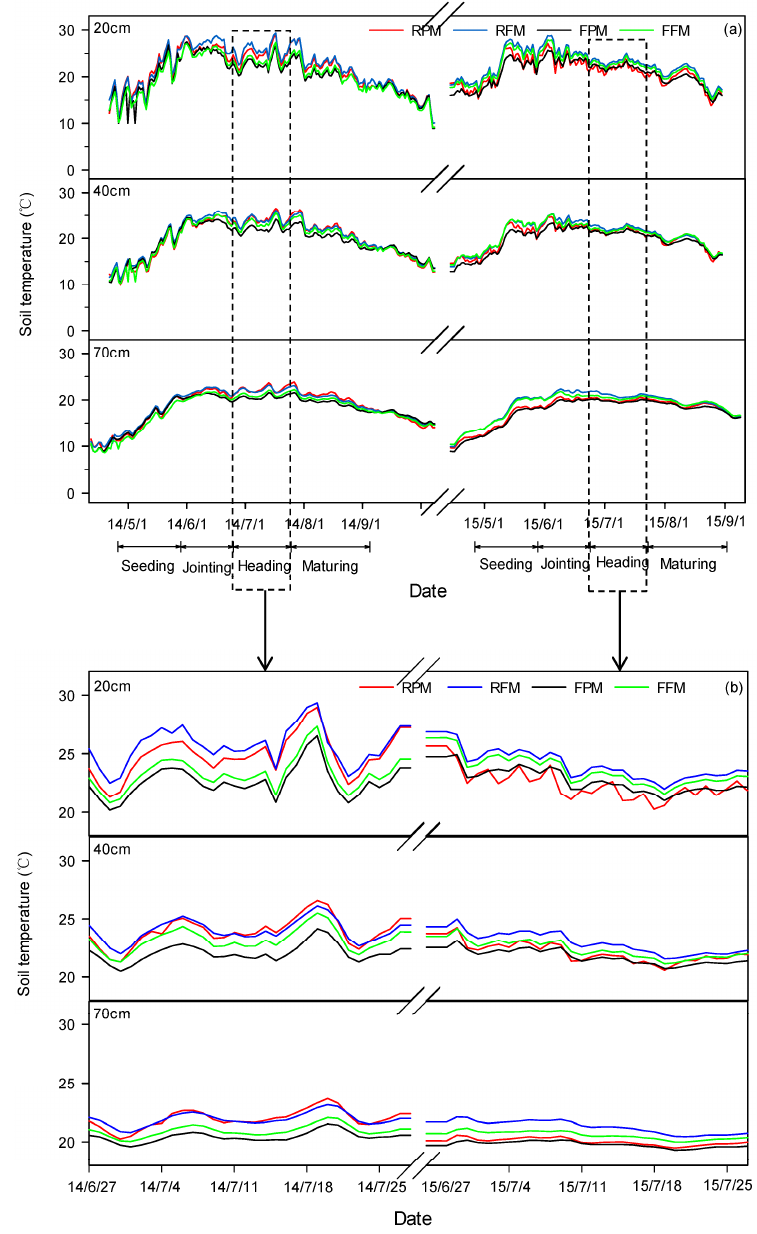
Figure 6. Daily average soil temperature of 0–70-cm layer in different treatments ( a ) during the growth period in 2014 and 2015 and ( b ) during the heading stage in 2015.